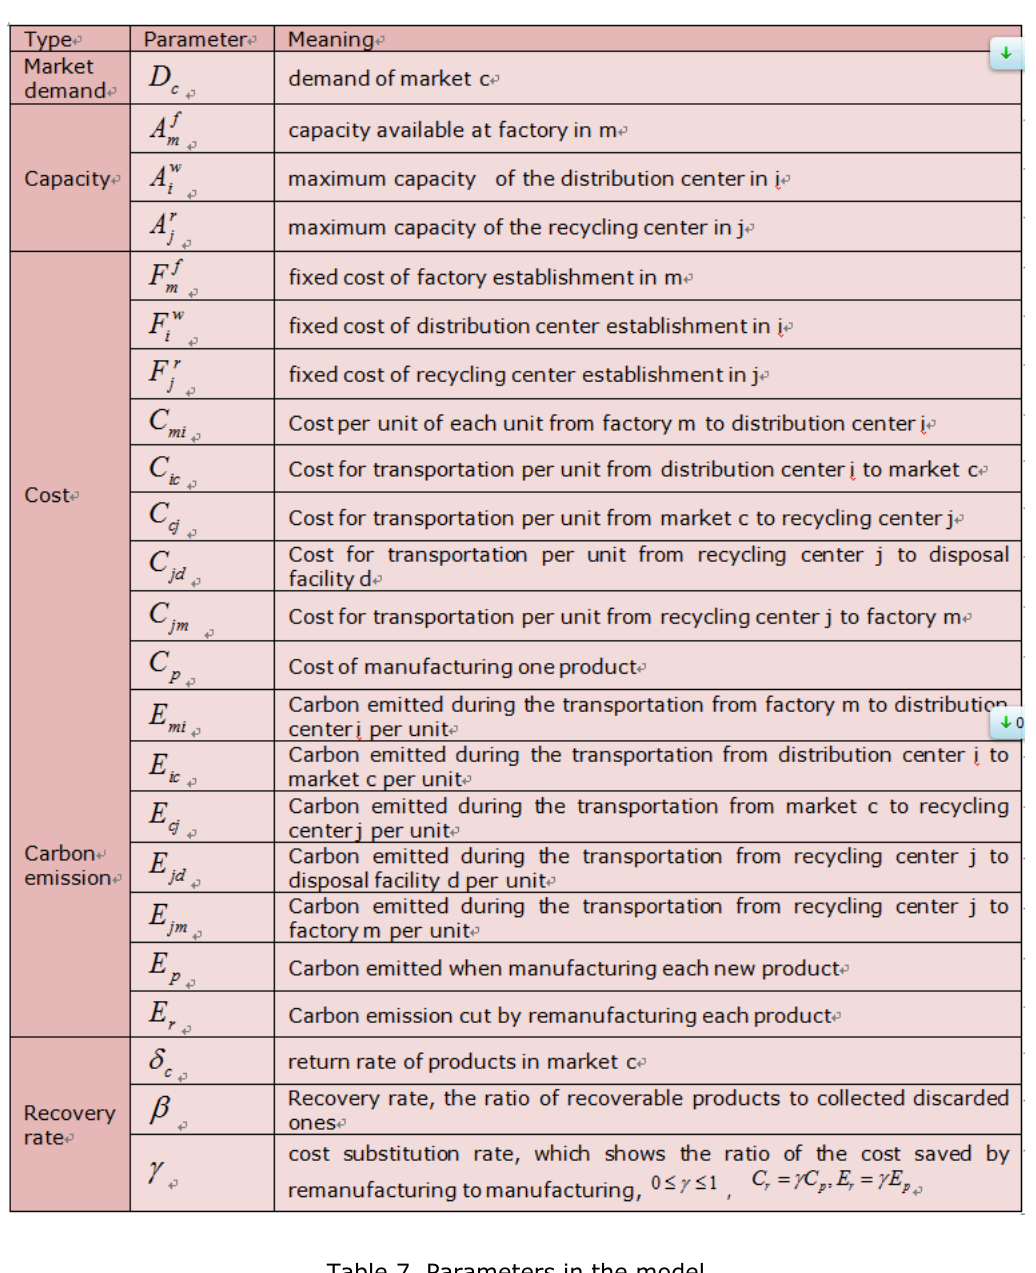
Table 7. Parameters in the